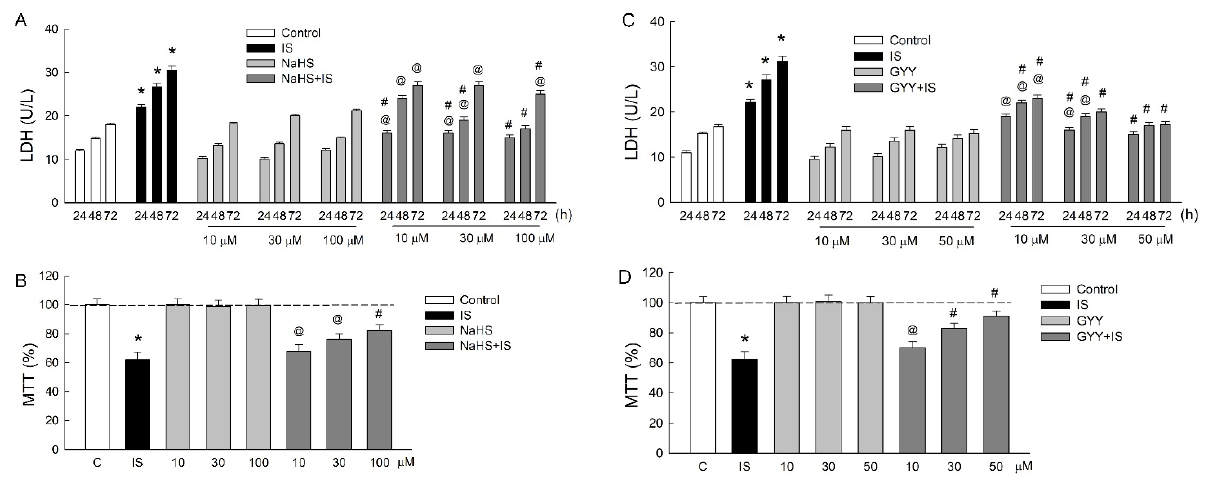
Figure 1. Supplementation with H 2 S attenuates IS-induced tubular damage. The responses to IS and two H 2 S donors NaHS and GYY-4137 (GYY) were evaluated in LLC-PK 1 cells. ( A , C ) The amount of LDH released was determined following treatment with IS or an H 2 S donor, either alone or in combination for 24, 48, and 72 h. ( B , D ) Cell viability was examined using the MTT assay after 72 h of treatment. N = 6 for each time-point and treatment. * p < 0.05, IS vs. control group; @ p < 0.05, NaHS + IS or GYY + IS vs. NaHS or GYY group, respectively; # p < 0.05, NaHS+IS or GYY + IS vs. IS group at the same